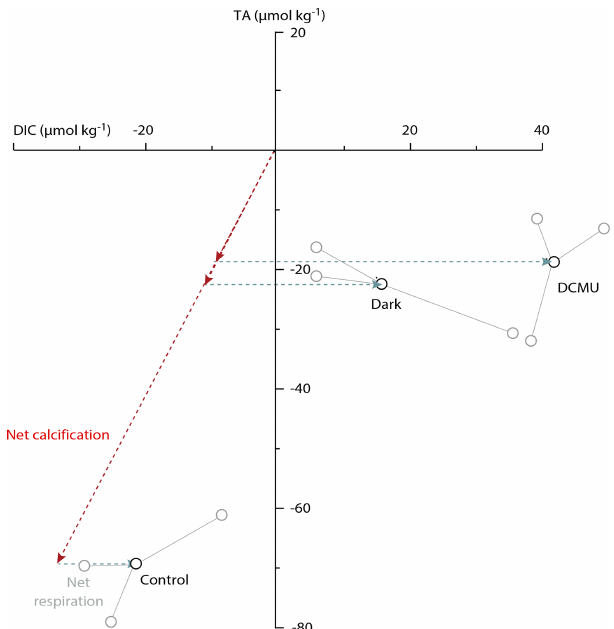
Figure 4. Changes in total alkalinity versus that in DIC for incu- bations in light–dark alternation (control), in the dark and with the photosynthetic inhibitor DCMU. Every black circle represents the average change in T A and DIC between the initial and the final val- ues for each triplicate. The three gray circles show the measured DIC– T A combination for each of the triplicate measurements within every of the three treatments. For the “dark” and “DCMU” treat- ments, the individual DIC– T A combinations are connected to the average value. Arrows show the calcification (red) and net respira- tion (blue)